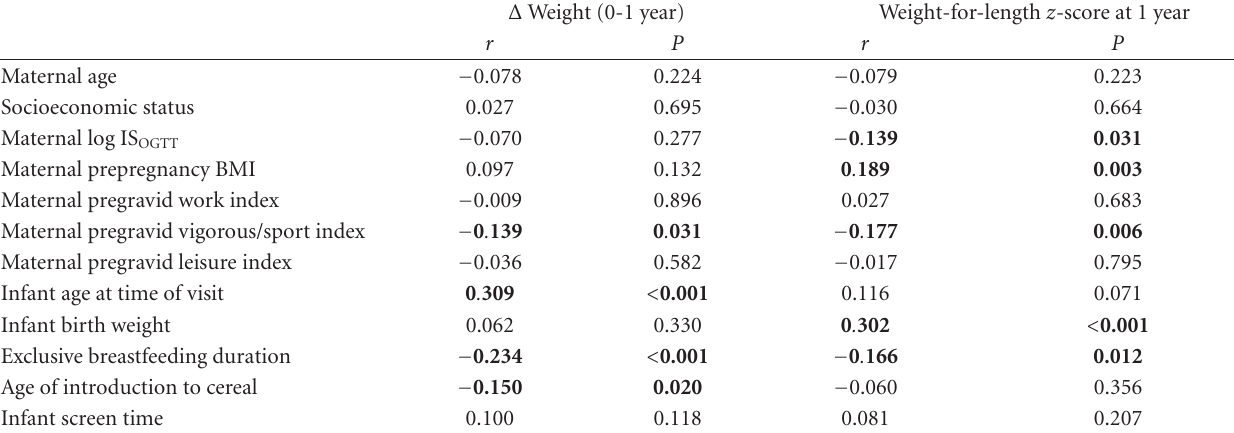
Table 2: Spearman’s rho correlation for Δ weight from 0-1 year and weight-for-length z -score at 1